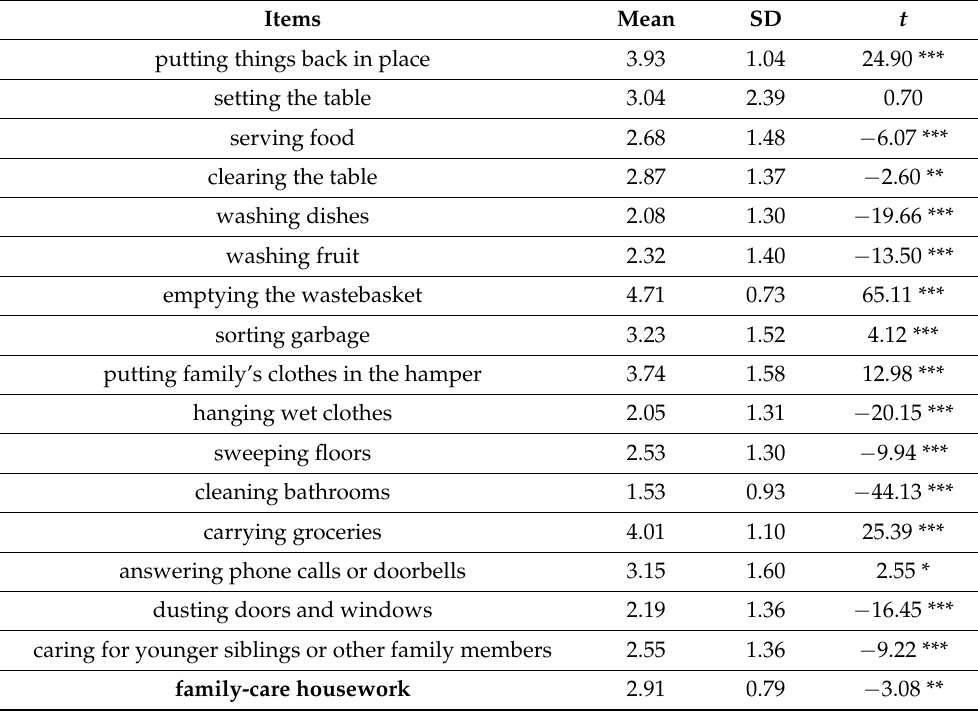
Table 2. Descriptive statistics of family-care housework (N =